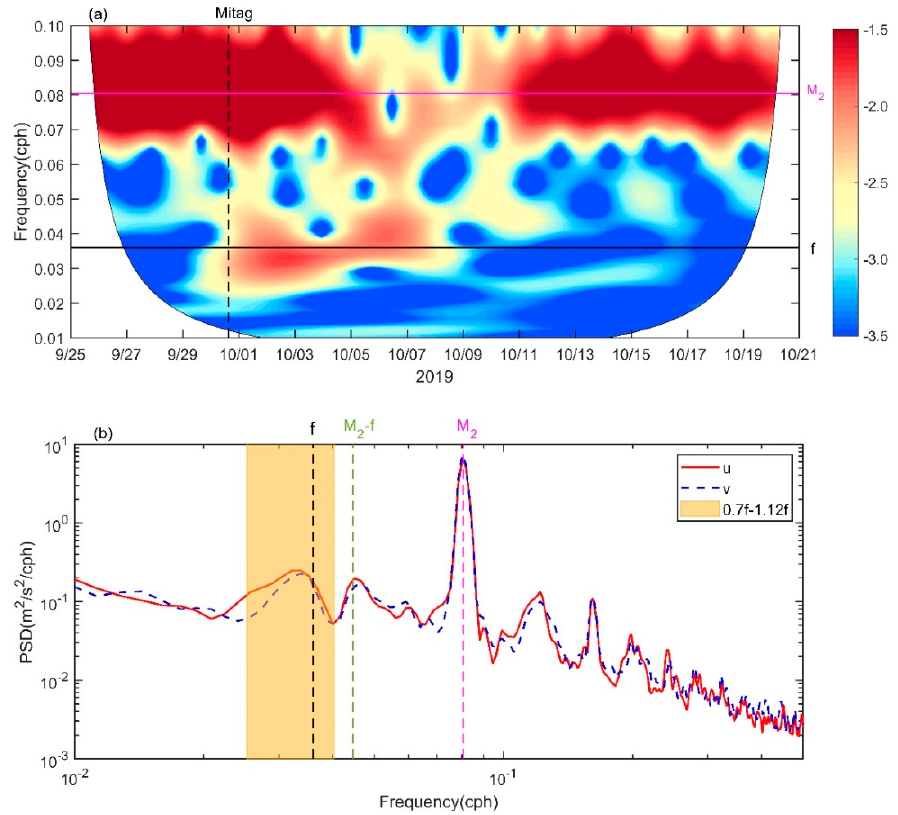
Figure 4. ( a ) Log of the magnitudes (shading) of the continuous wavelet transform of the zonal residual currents at a depth of 100 m at the mooring as a function of time and frequency. The horizontal black solid line and purple solid line indicate the local inertial frequency f and M 2 internal tides. The vertical black dashed lines denote the time when Mitag passed (15:00 on 30 September 2019). ( b ) Depth-averaged (from 50 to 540 m) power spectra of the zonal (red solid line) and meridional (blue dashed line) residual currents. The dashed lines denote the local inertial frequency f (black), the frequency of M 2 – f (light green), and the frequency of M 2 internal tides (purple). The yellow shading denotes the cutoff frequency for